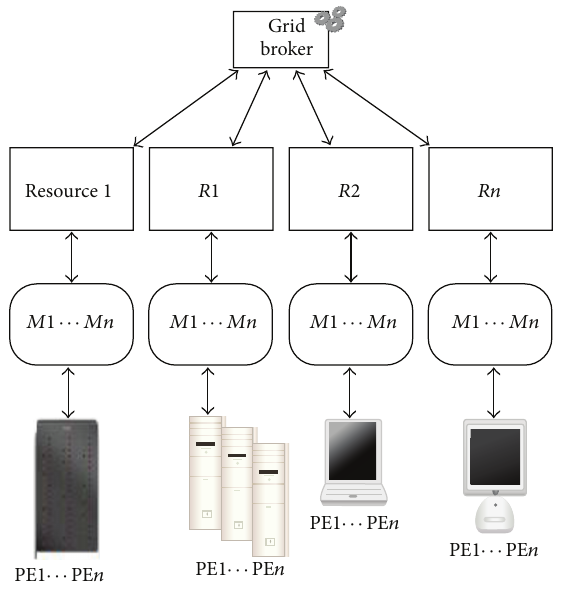
Figure 1: Centralized scheduling